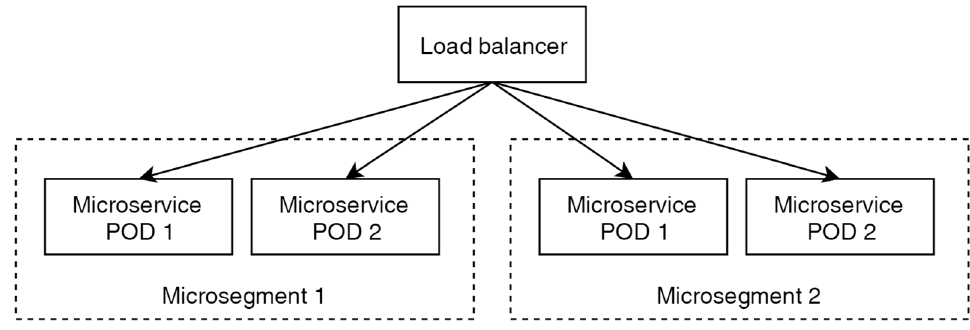
Figure 22. Microservice deployment into the cloud schema.